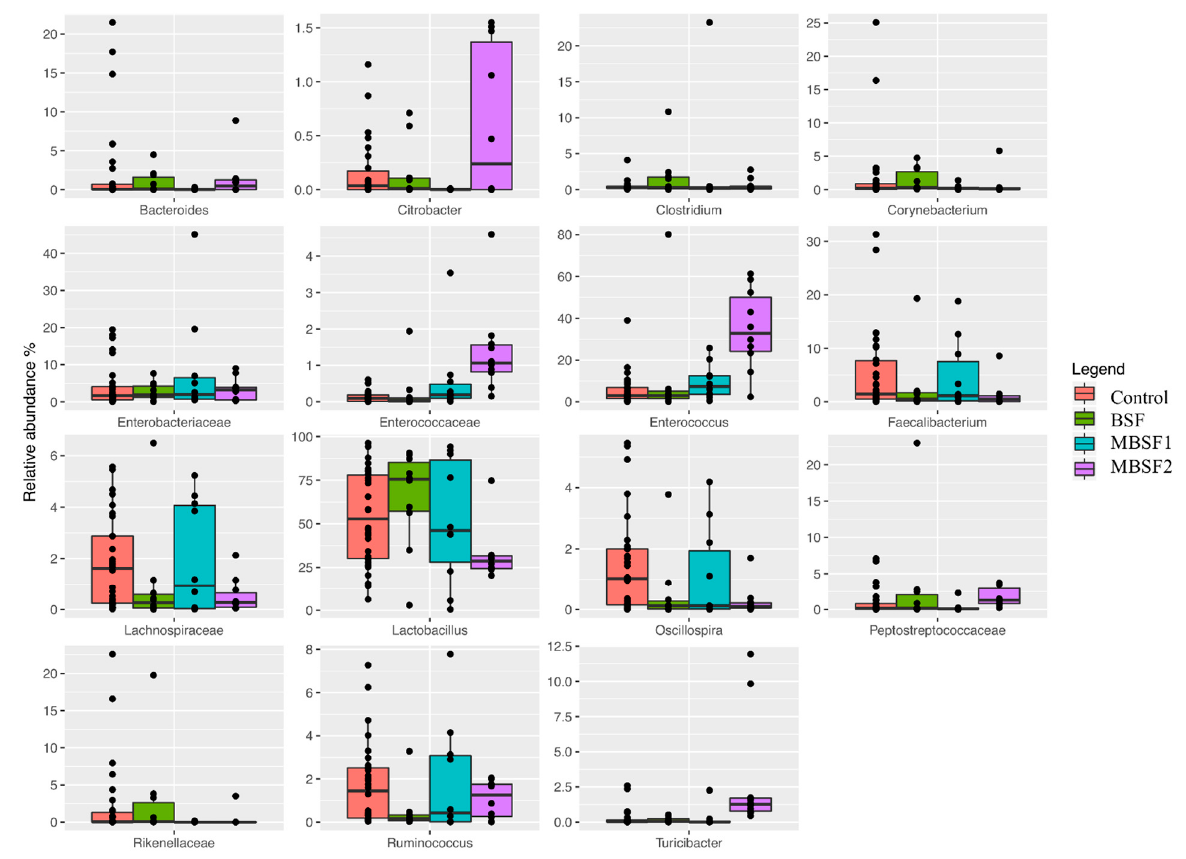
Figure 4. Boxplots showing the relative abundance at genus or family level of the OTUs differentially abundant based on generalized linear mix model ( p ≤ 0.05) in fecal samples of broiler chickens independently of sampling time. BSF = diet with black soldier fly larvae fat; MBSF1 = diet with modified black soldier fly larvae fat type 1; MBSF2 = diet with modified black soldier fly larvae fat type